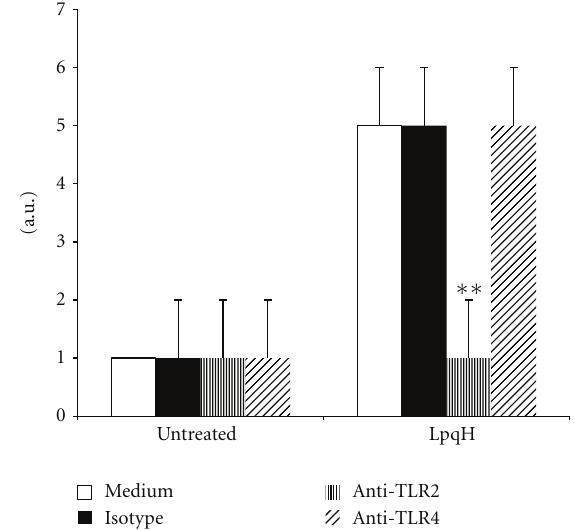
Figure 2: LpqH triggers a TLR2 cell death program. To determine a possible role of TLR2 in MO apoptosis, inhibition assays were performed using a specific mAb known by its ability to block TLR2 activation; 0 . 5 × 10 6 cells were preincubated with 20 μ g antibody for 1 h and then with 5 μ g LpqH to induce apoptosis. A similar procedure was used to analyze the participation of TLR4. Apoptosis was analyzed with a nucleosome ELISA kit. Values are given as the mean ± SE of four independent experiments. Statistically significant di ff erences are indicated; ∗∗ P < 0 .